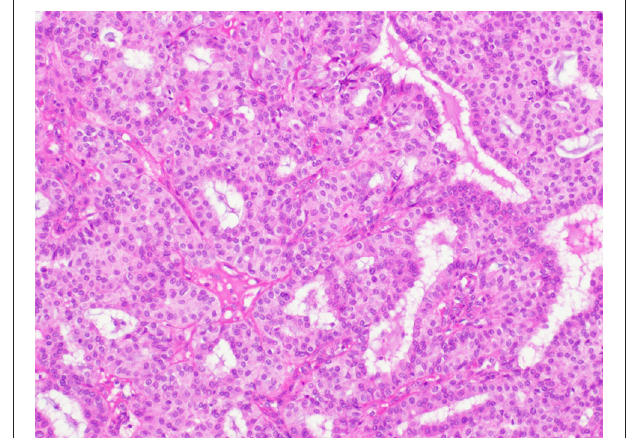
FIGURE 1 | Histological findings of encapsulated papillary carcinoma (EPC). The tumor nodule is surrounded by a thick fibrous capsule.